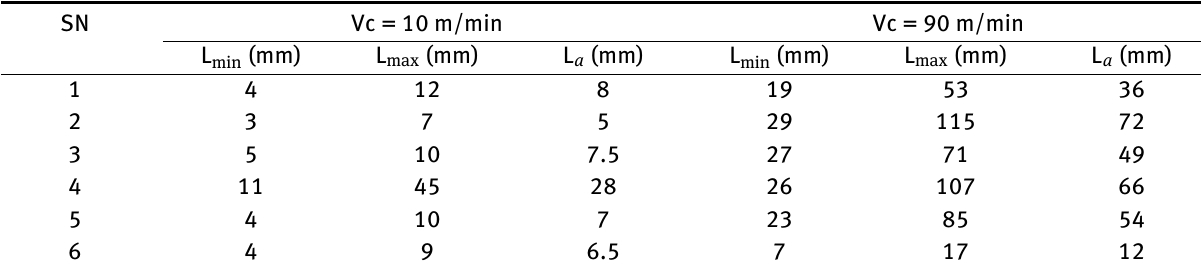
Table 9: The measured length of chip shape style.